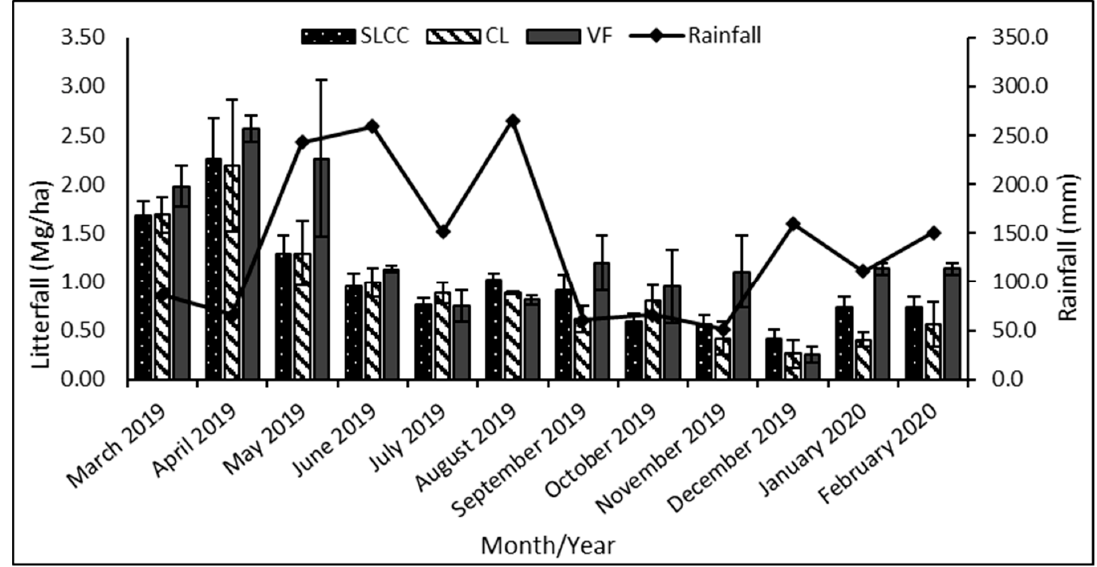
Figure 3. Mean monthly litterfall (Mg ha − 1 ) production in supervised logging with climber cutting plots (SLCC), conventional logging plots (CL), and virgin forest plots (VF) at Gunung Rara Forest Reserve, Sabah, Malaysia, from March 2019–February 2020. Error bars represent the standard error for the measurements.